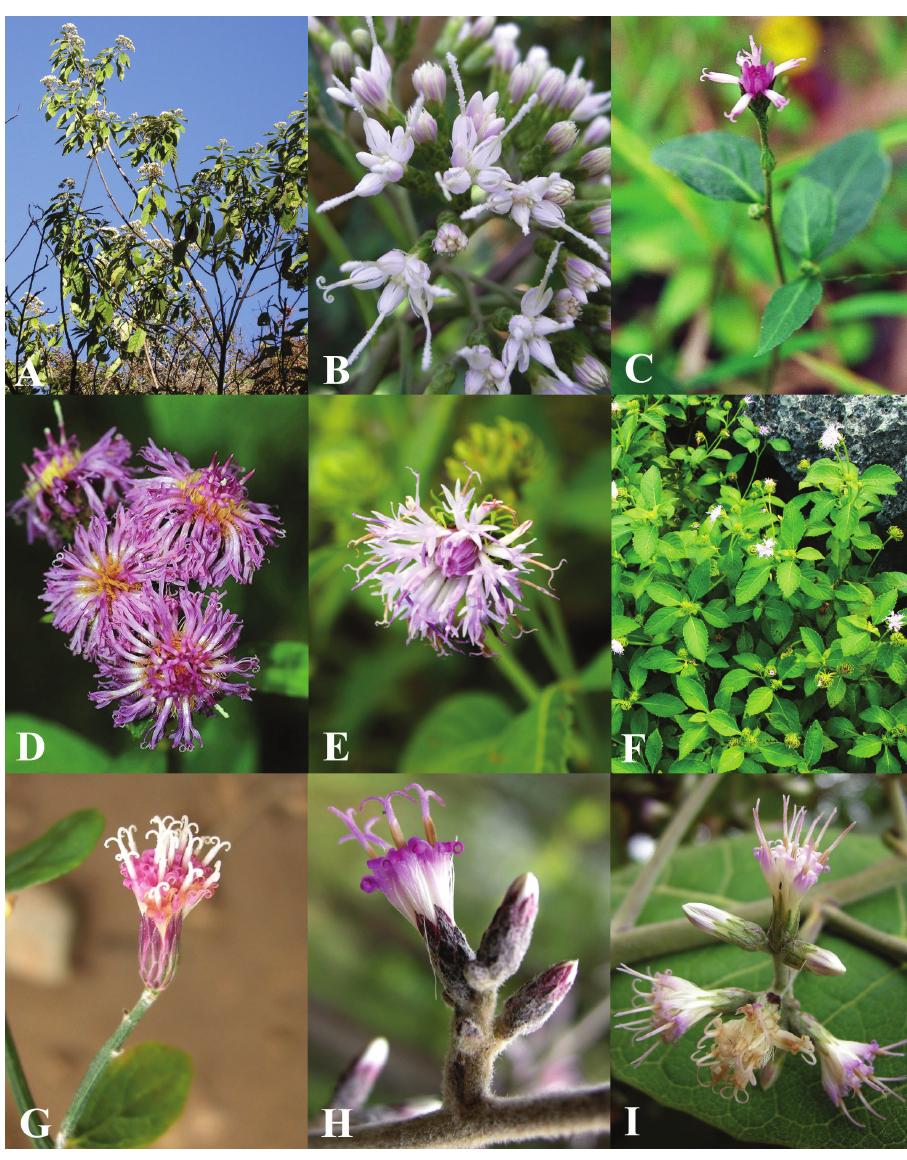
Figure 9. Morphology of Vernonieae in Thailand 5. A–B Gymnanthemum extensum C Iodocephalopsis eber- hardtii D Koyamasia calcarea E–F Koyamasia curtisii G Kurziella gymnoclada H Monosis parishii I